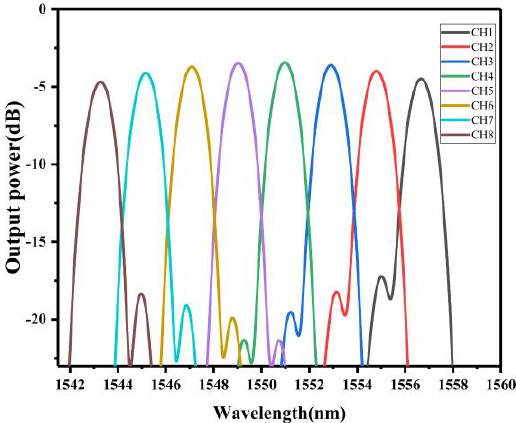
Figure 6. Simulation results of saddle-shaped 8 × 8 AWG.